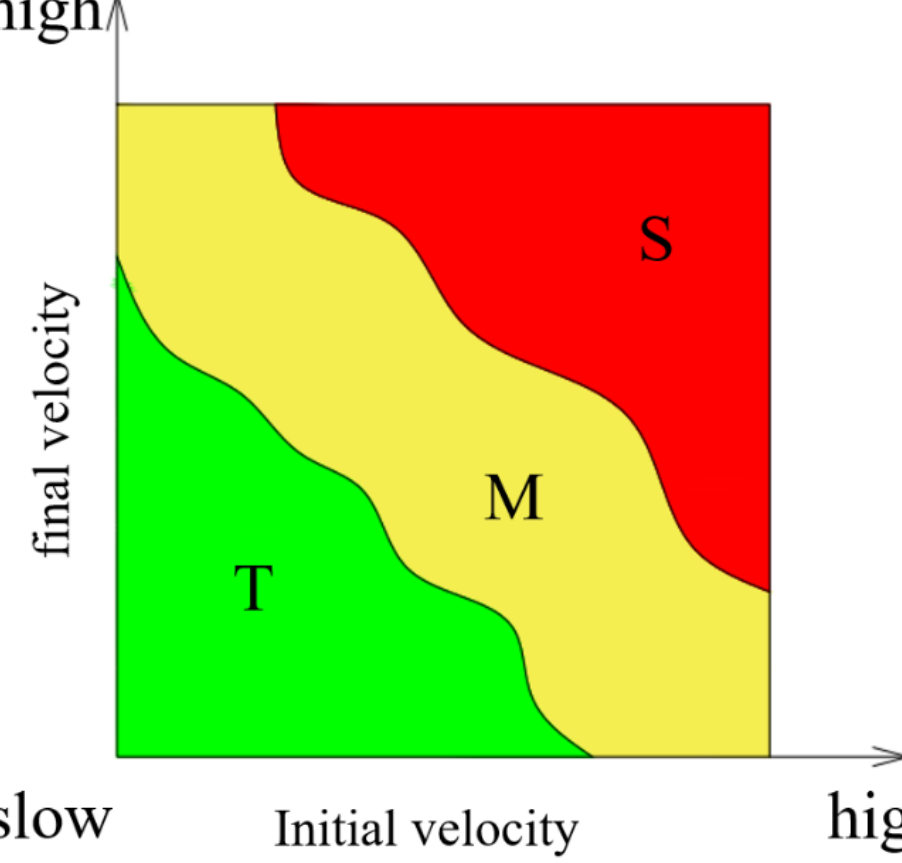
Figure 8. Diagram of relationship between sudden change rate loading mode and final failure mode.